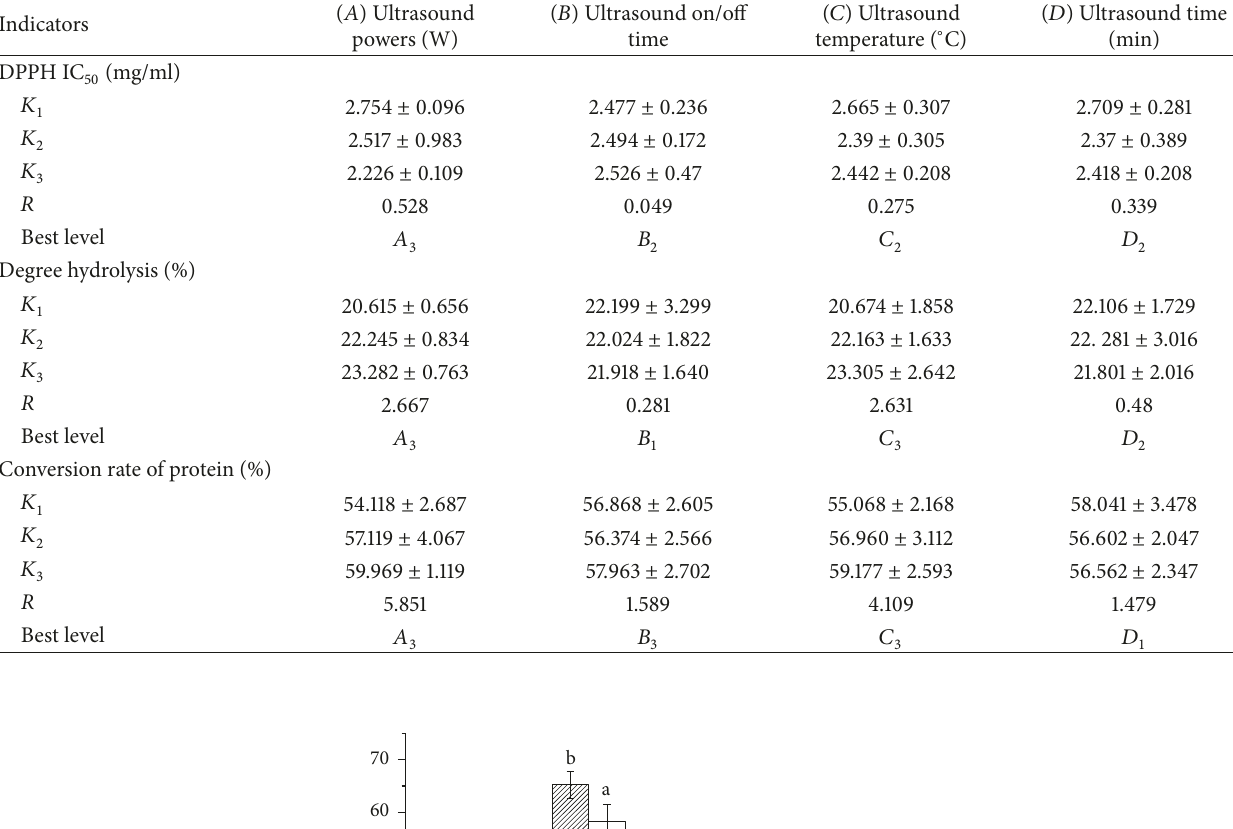
Table 3: Range analysis ( 𝑅 ) on indicator parameters obtained from the L 9 (3 4 ) orthogonal experiment ( 𝑛 = 3 , mean ± SD).